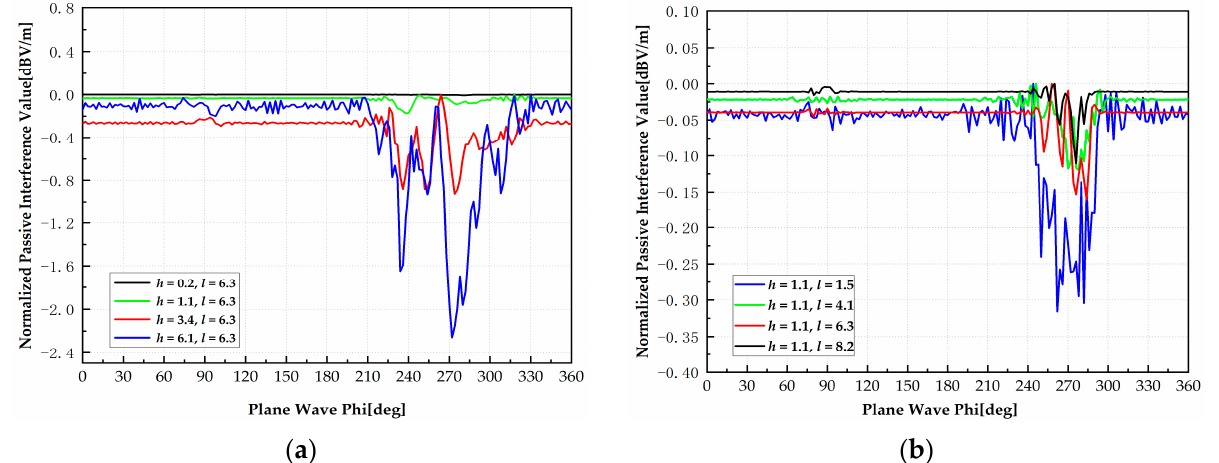
Figure 8. Passive interference values of RMS height and relevant length at different levels. ( a ) RMS height h as variable; ( b ) Relevant length l as variable.